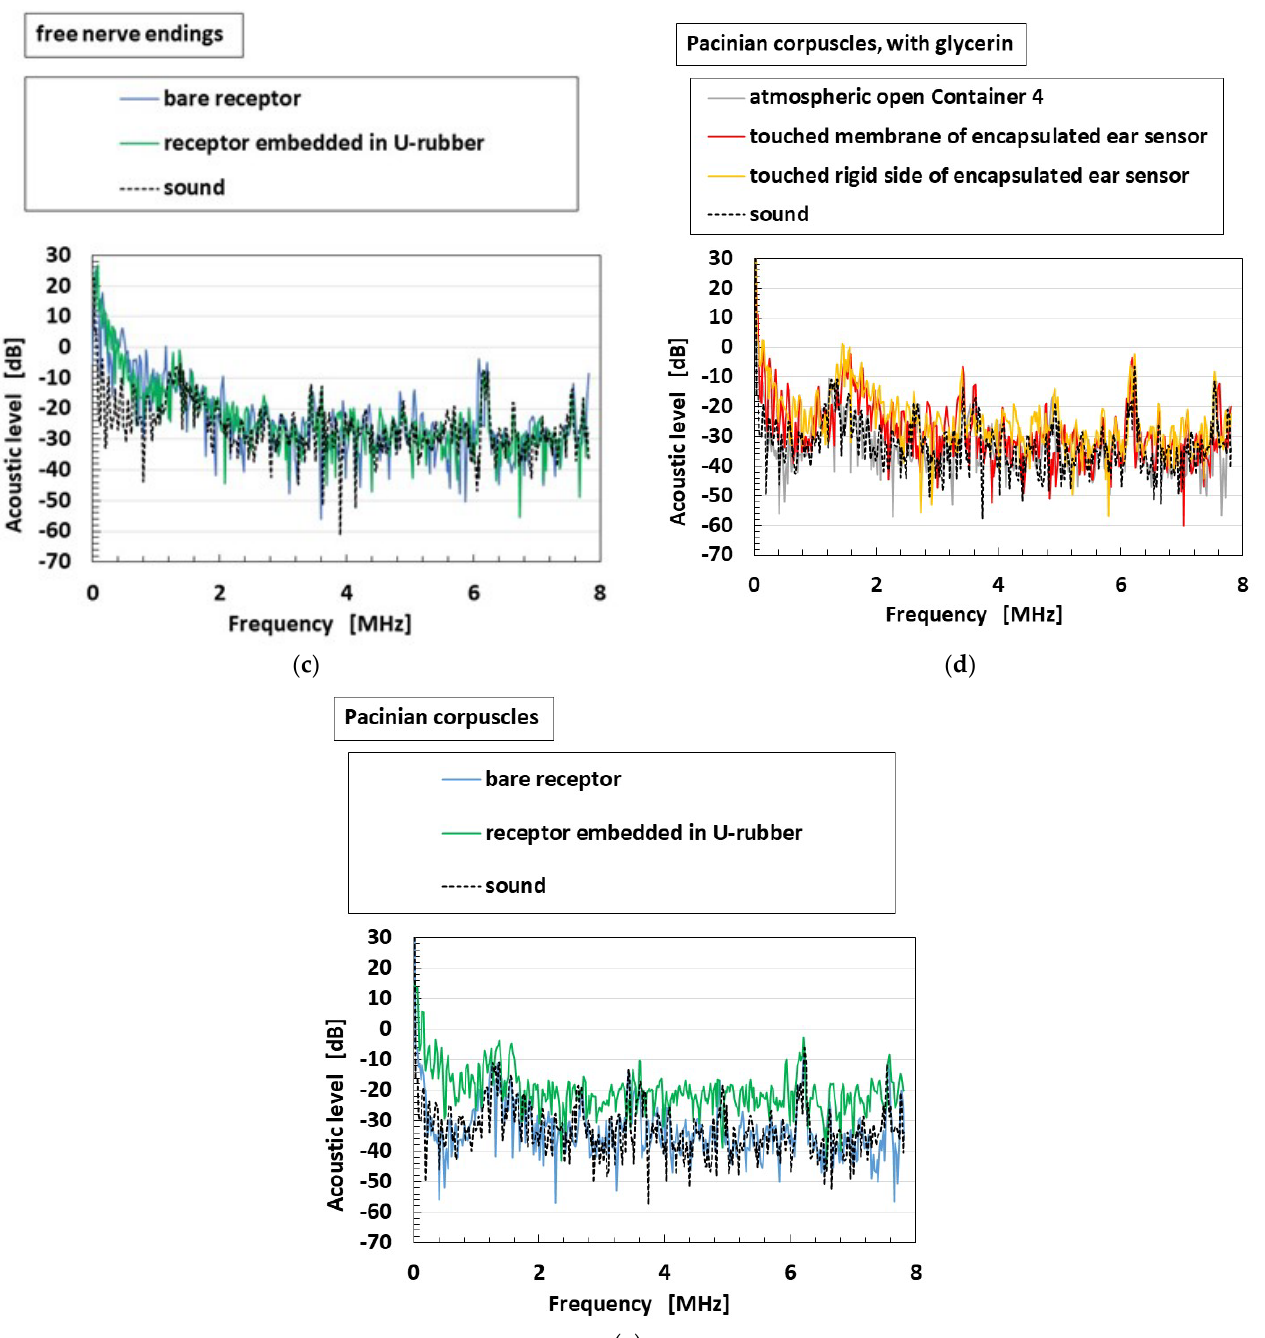
Figure 21. Experimental results of the vibrating auditory sensor on the sound level of a speaker when each receptor and sensor are compared: ( a ) with free nerve endings in water; ( b ) with free nerve endings in glycerin; ( c ) with free nerve endings; ( d ) with Pacinian corpuscles in glycerin; ( e ) with Pacinian corpuscles.